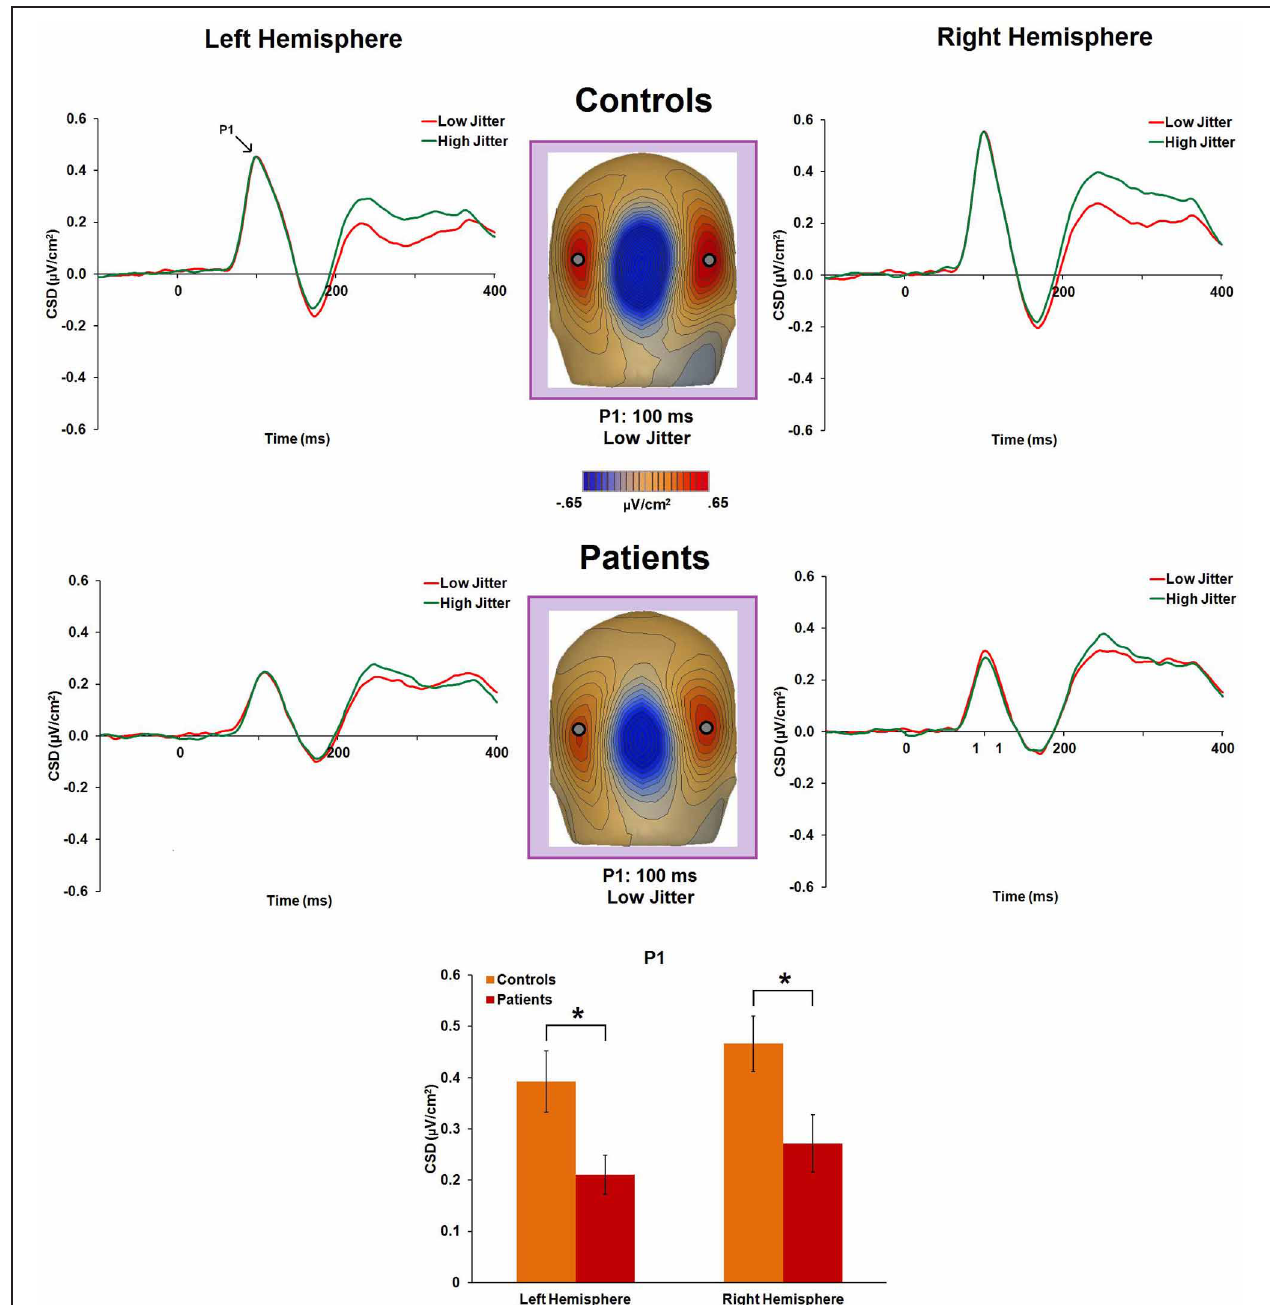
FIGURE 3 | Event-related potential CSD responses to low- and high-jitter stimuli from occipital electrodes (left hemisphere: P3, P5, PO7; right hemisphere: P4, P6, PO8) for the P1 component. The graphs indicate no significant differences between the jitter conditions in